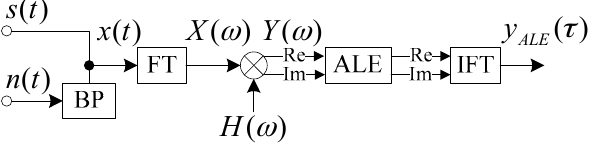
Figure 4. Block diagram of the frequency-domain adaptive matched filter (FDAMF).